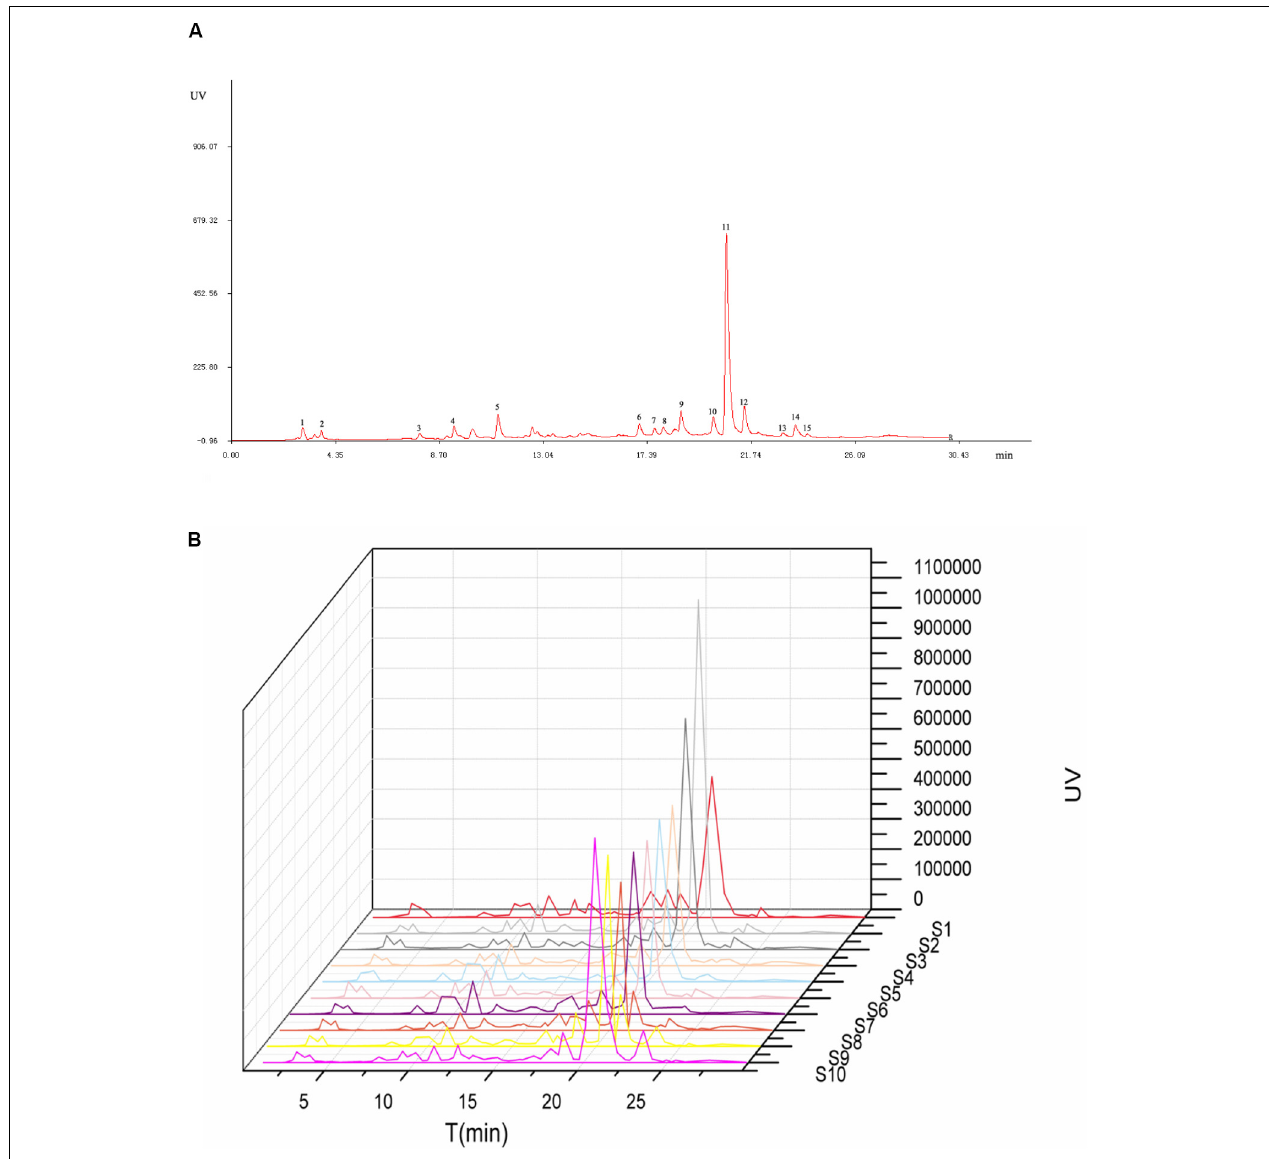
FIGURE 2 | Chromatographic fingerprints for reference (A) and all the Syringa oblata sample (B)